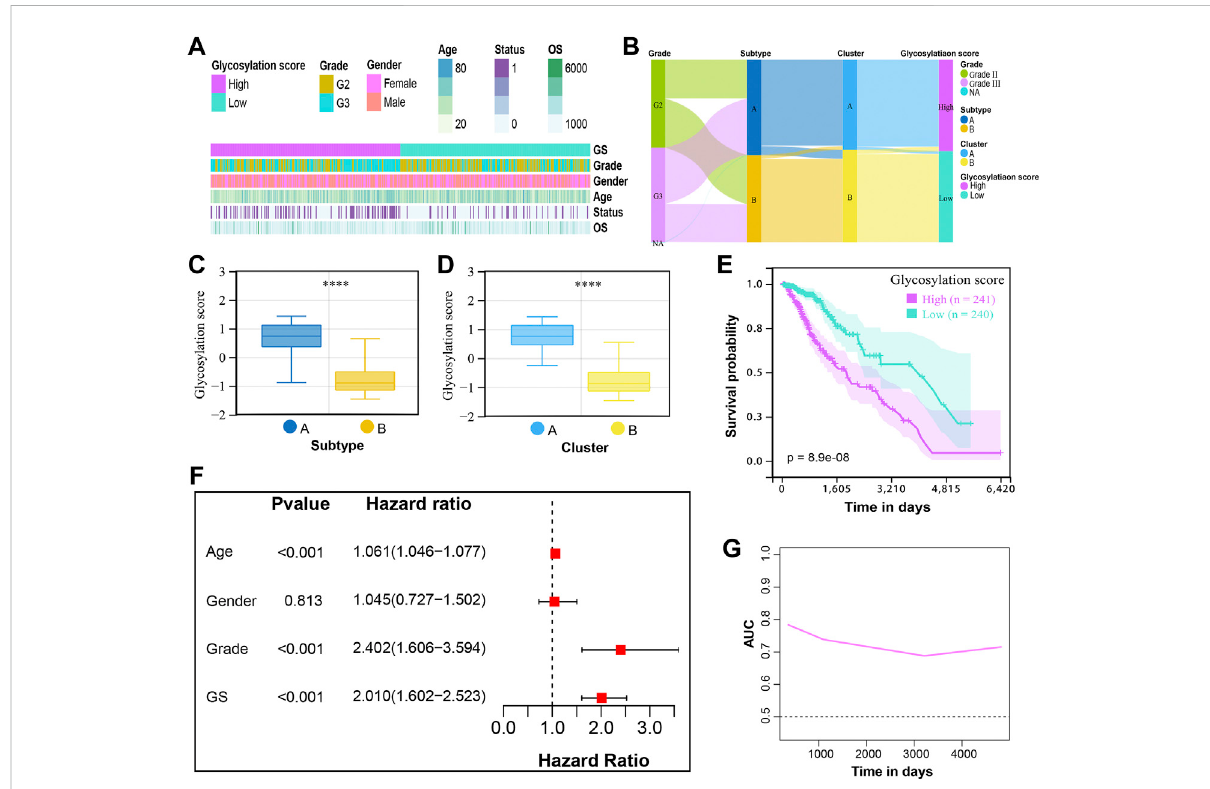
FIGURE 5 DevelopmentoftheglycosylationscoringsystemanditsprognosticvaluesforLGGs. (A) Clinicalfeaturesinthehighandlowglycosylationscore subgroups. (B) Alluvial diagram of glycosylation score in groups with different grades, subtypes, and clusters. The boxplot showed the distribution of glycosylation score in the different (C) subtypes and (D) clusters. The p -values were both less than 0.0001. (E) K-M curves for patients with low and high glycosylation scores. (F) Multivariate Cox regression analysis for the glycosylation score and clinical variables. GS, glycosylation score. (G) Time-dependent AUC value of the glycosylation score demonstrated it as a robust and reliable prognostic